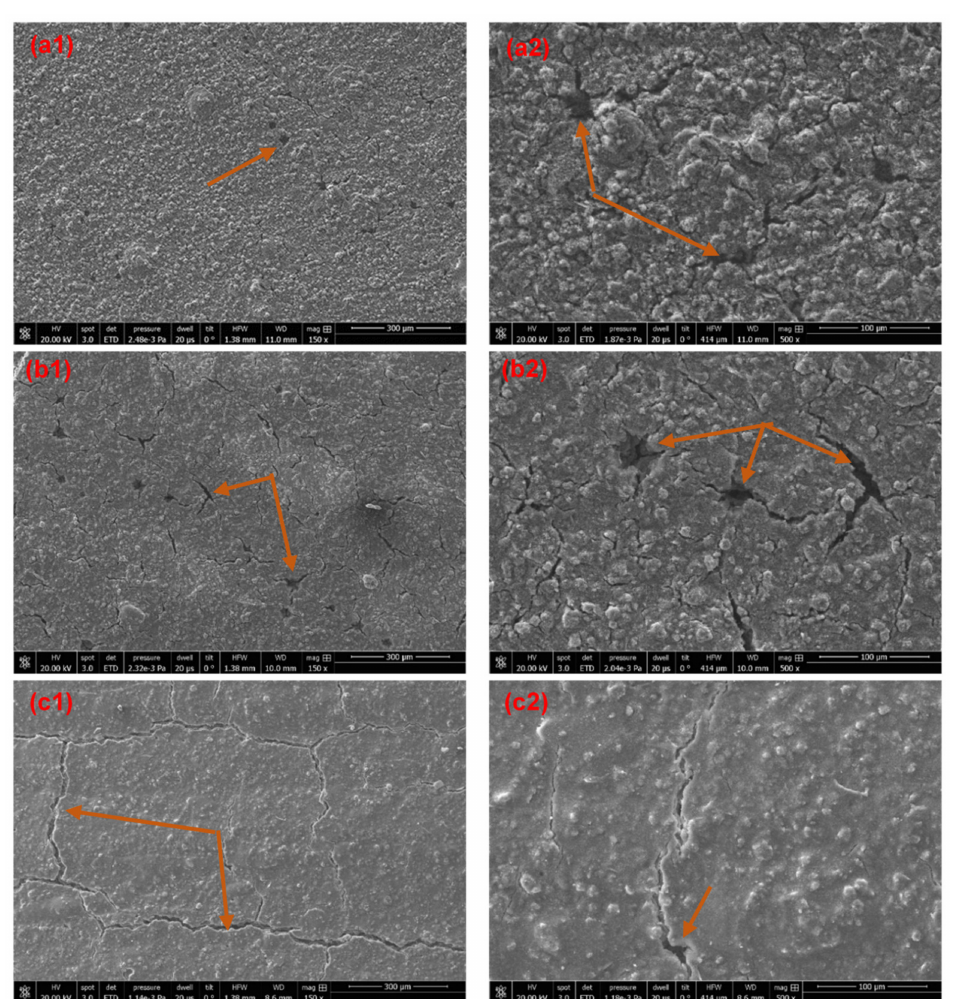
Figure 7. SEM Micrographs of cured SW1 ( a1 , a2 ), SW2 ( b1 , b2 ), and SW5 ( c1 , c2 ) (the arrows indicate cracks and